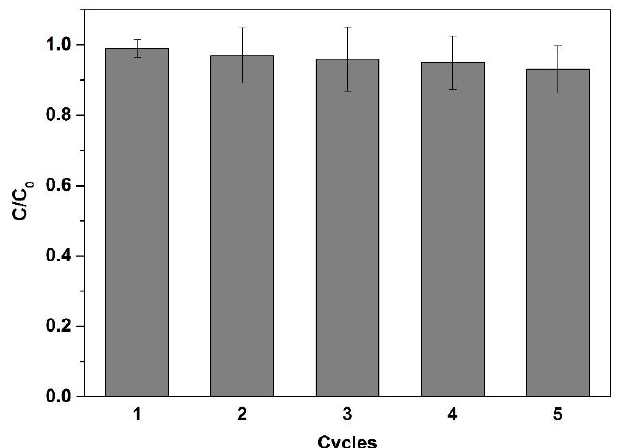
Figure 6. A ffi nity microfiltration e ffi ciency of the glycosylated membrane after repeated use (all Figure 6. Affinity microfiltration efficiency of the glycosylated membrane after repeated use (all experiments were repeated three experiments were repeated three times).